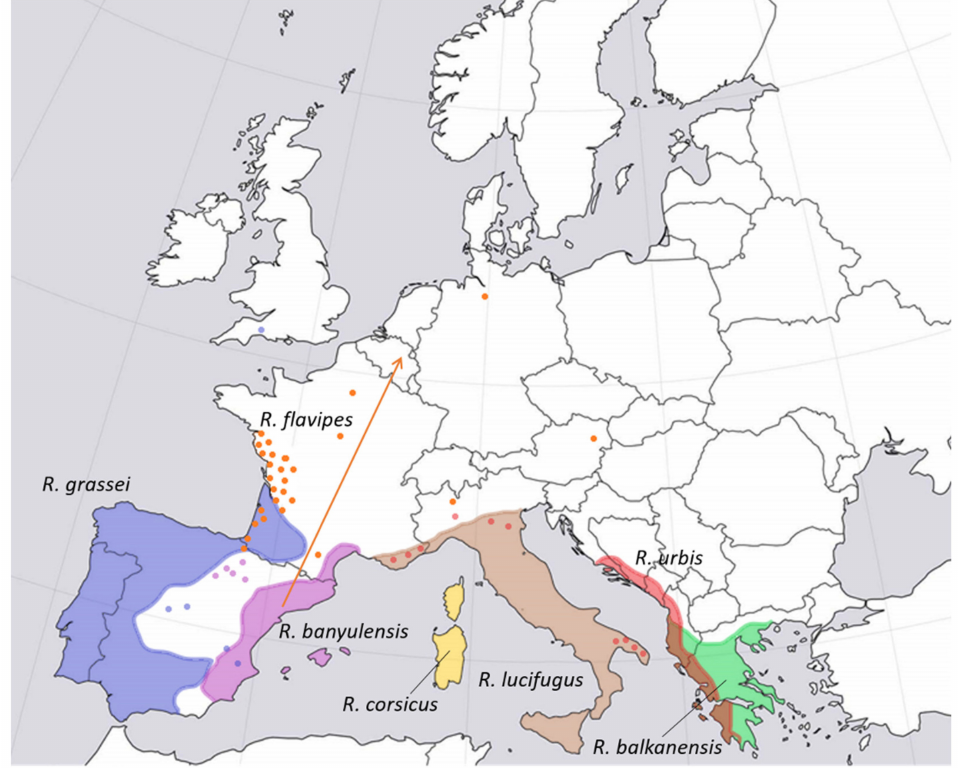
Figure 5. Approximate distribution of the main species of subterranean termites of the genus Reticuliermes present in Europe. All species are considered native except for R. flavipes , which is native to North America. Dots represent introductions, and colored areas represent natural distribution ranges. The orange arrow represents the shift vector of the center of gravity of the potential distribution of R. flavipes due to global change. Adapted from